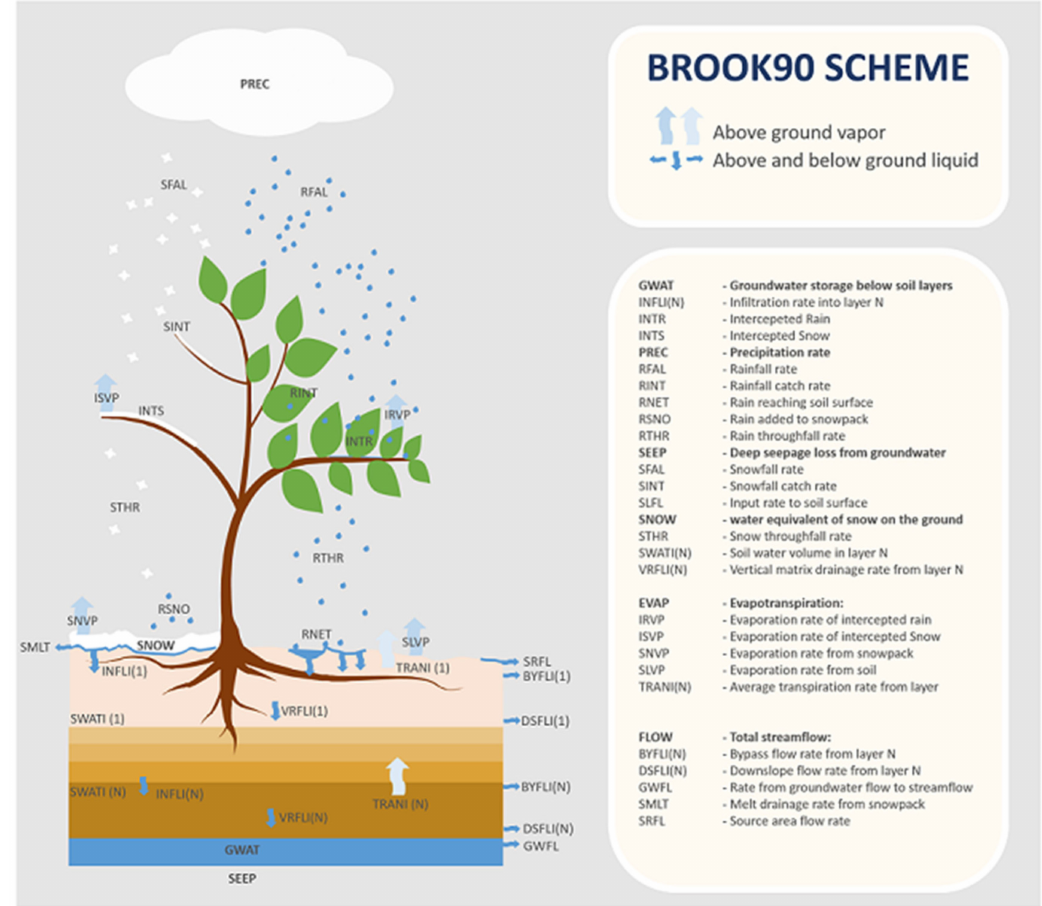
Figure 1. Water fluxes and processes represented in BROOK90